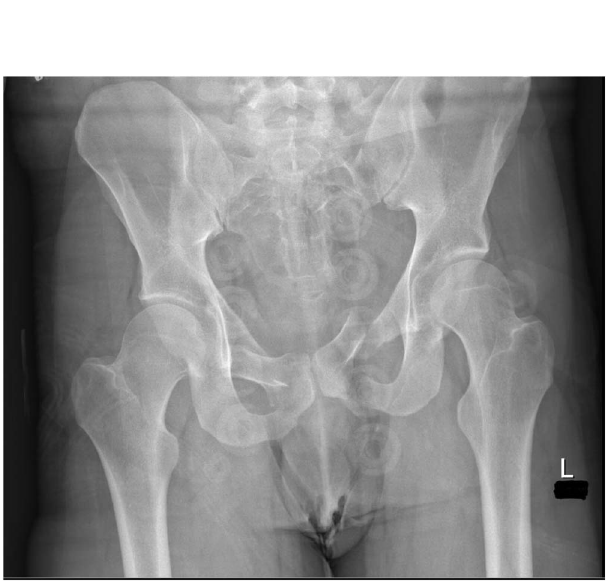
Figure 1. Initial imaging of a combined mechanism pelvis injury.